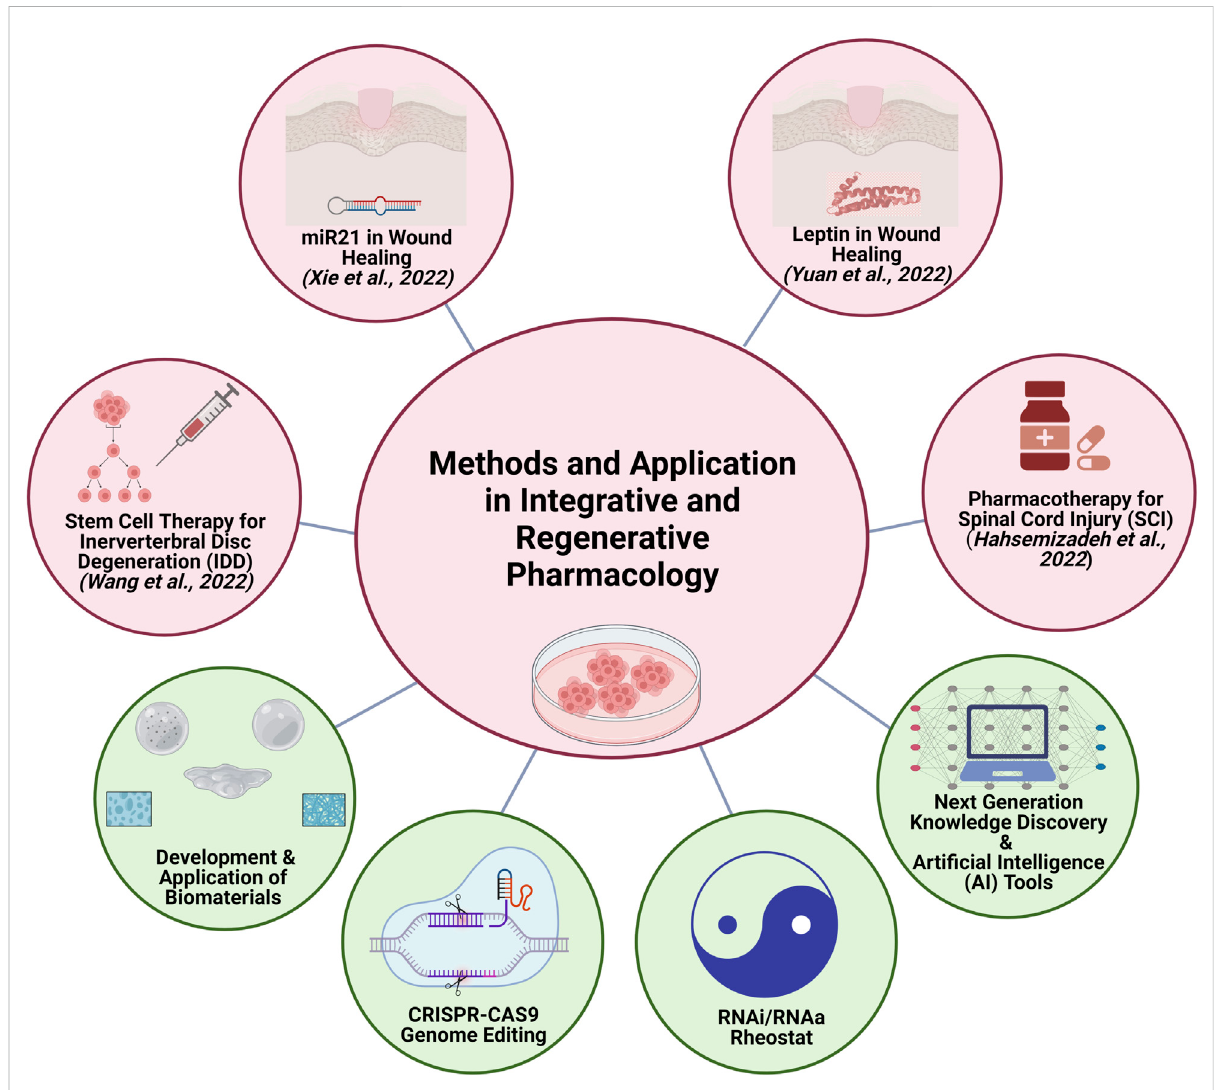
FIGURE 1 Methods and Application in Integrative and Regenerative Pharmacology. Articles in the special issue (light red circles) address the role of miR21 and leptin in wound healing, stem cell therapy for intervertebral disc degeneration (IDD), and pharmacotherapy for experimental spinal cord injury (SCI) in rats. The future of integrative and regenerative pharmacology (light green circles) depends on research advances in the development and application of biomaterials, CRISPR-CAS9 Genome Editing, RNAi/RNAa rheostat, and next generation knowledge discovery methods and arti fi cial intelligence (AI) tools ( Illustration created using BioRender